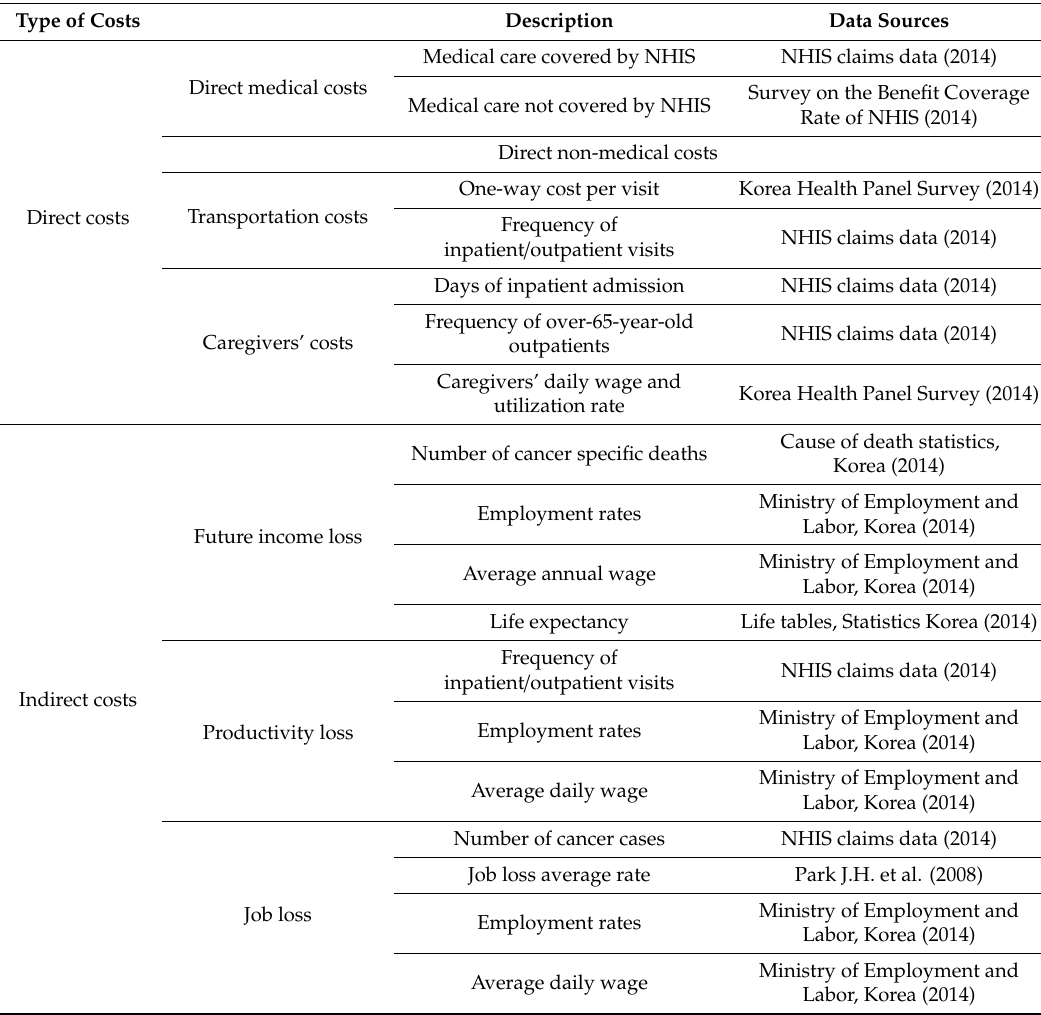
Table A1. Data sources that are used in direct and indirect costs estimation of infection-related cancers in the Republic of Korea.